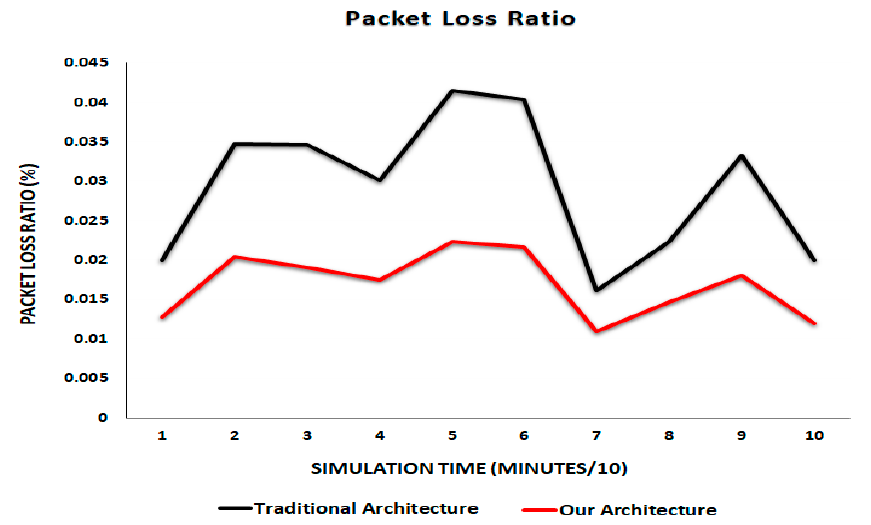
Figure 10. Packet loss